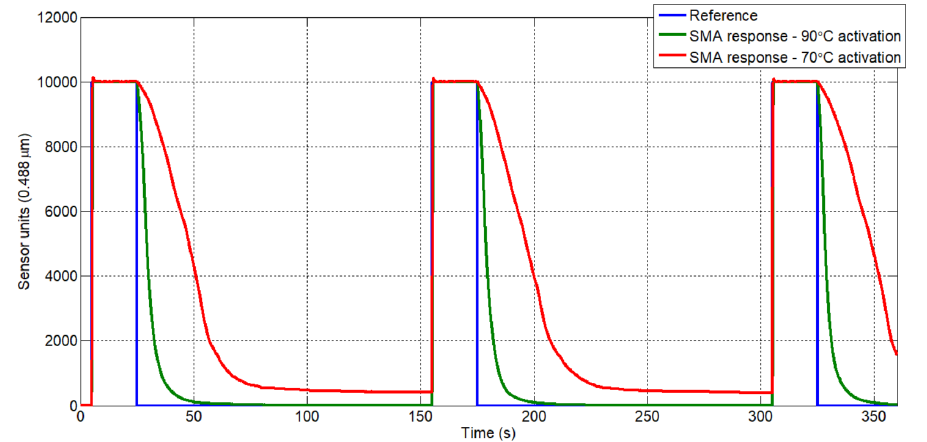
Figure 5. SMA actuator response: high temperature vs. low temperature.